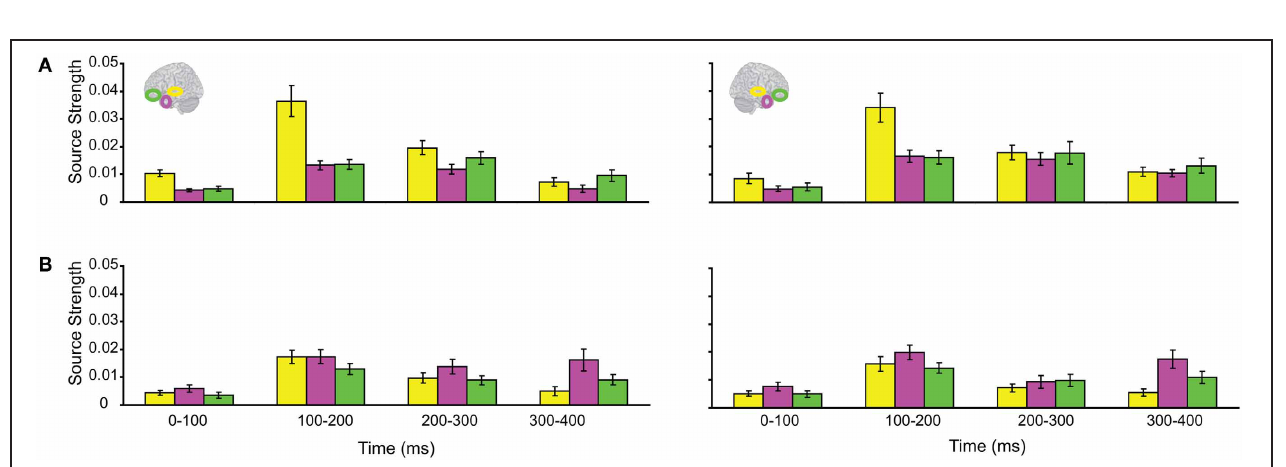
FIGURE 4 | Time-binned (100 ms) responses to auditory trials (same as Figure